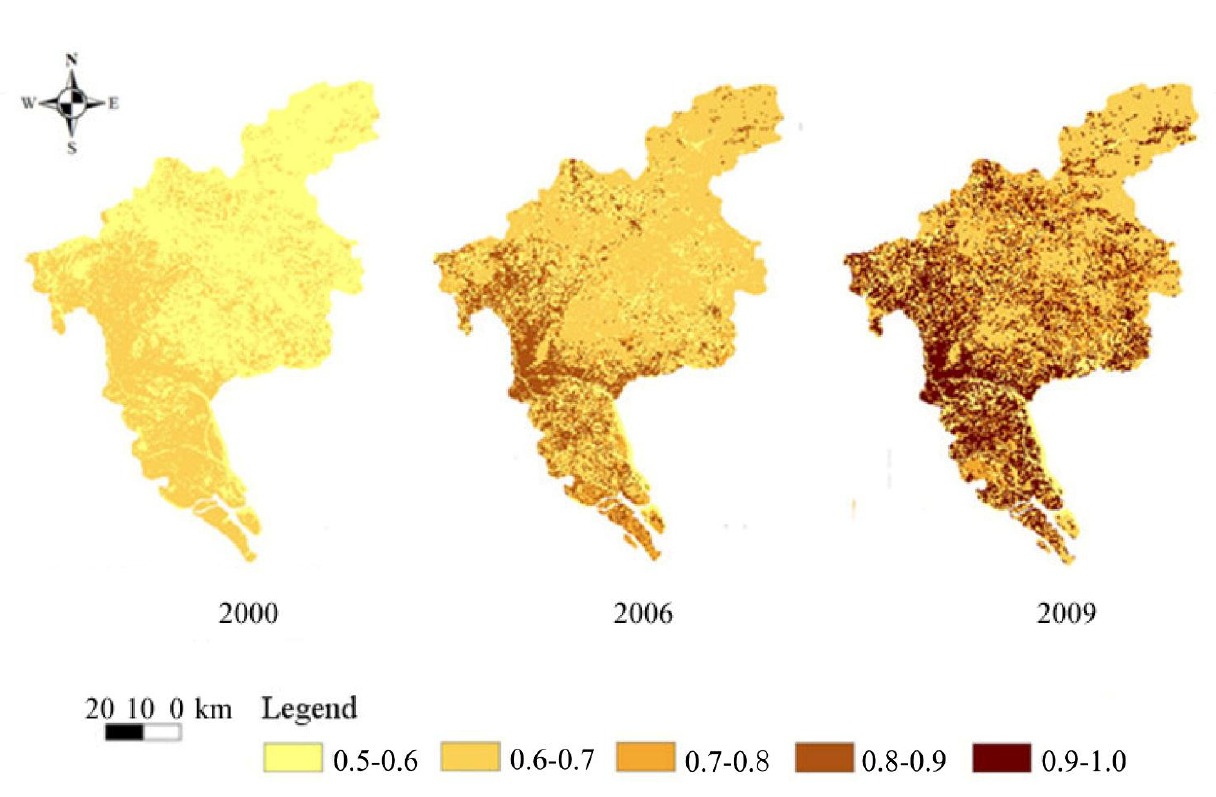
Figure 5. Spatial differentiation of unit demand